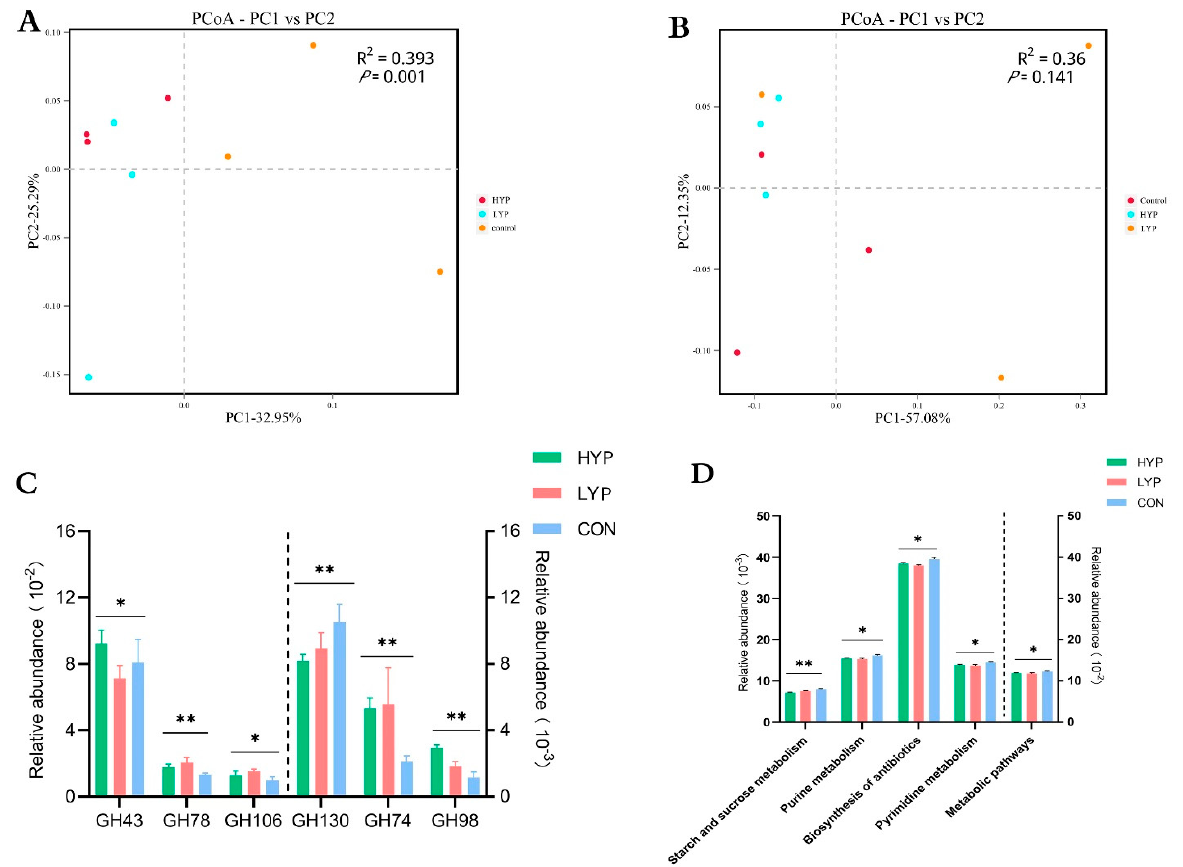
Figure 3. Effects of yeast product on the metabolic function profiles of rumen microorganisms. ( A ) PCoA of solid-associated (SA) microorganisms based on Binary–Jaccard distance in KO level. ( B ) PCoA of liquid-associated (LA) microorganisms based on Binary–Jaccard distance in KO level. ( C ) Comparisons of the gene abundance of the GH family members among three groups in the SA system. ( D ) The functional differences among three groups in SA microorganisms at KEGG-pathway level 3. * p < 0.05 and ** p < 0.01.